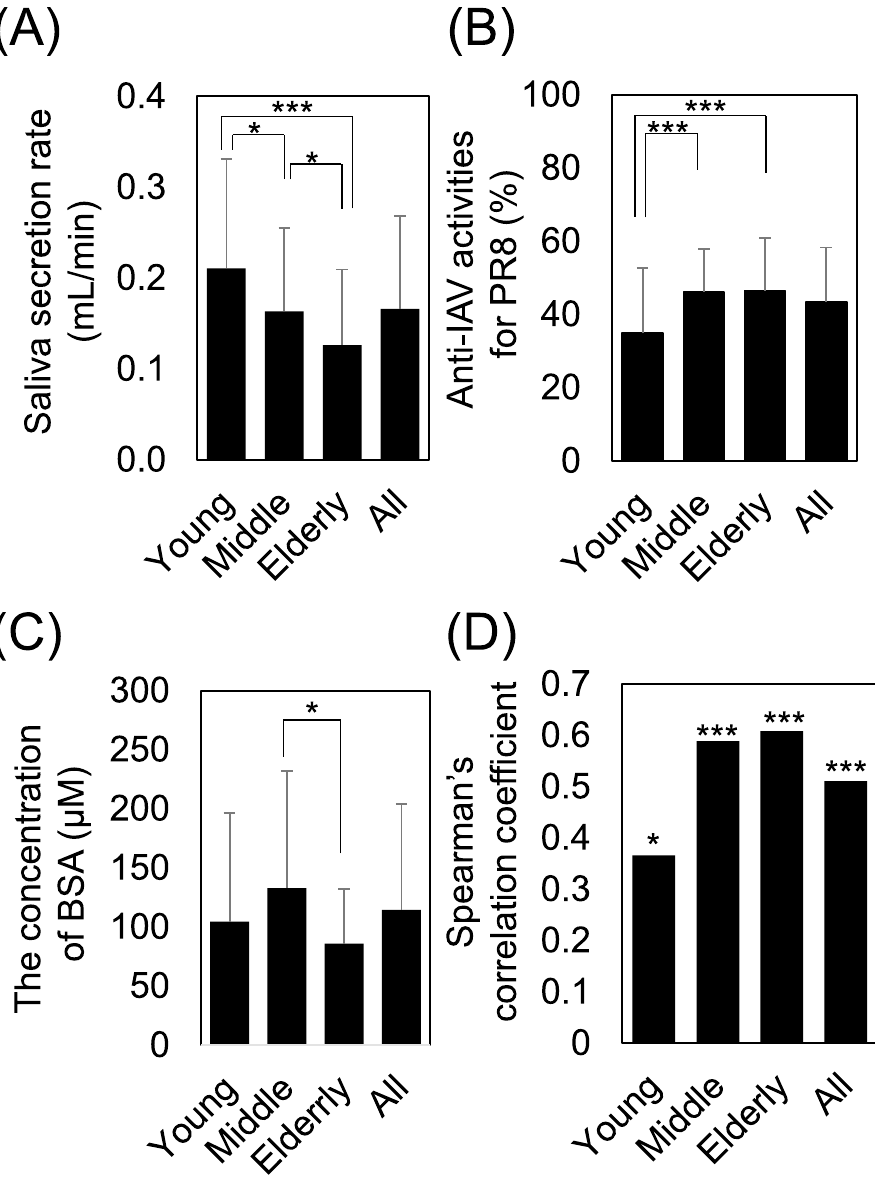
Figure 4. Age-related differences in salivary anti-IAV activity. Comparison of ( A ) the saliva secretion rate (mL/min), ( B ) salivary anti-IAV activity against the PR8 IAV strain, ( C ) BSA concentration in saliva, and ( D ) correlation between salivary anti-IAV activity against the PR8 IAV strain and the concentration of BSA in young people (30 boys and 30 girls aged 5–19 years), middle adults (60 men and 60 women aged 20–59 years), and elderly people (30 men and 30 women aged 60–79 years). Data are presented as mean ± SD of each group. Average plateau values were compared using one-way analysis of variance and the Kruskal–Wallis test. * p < 0.05; *** p <